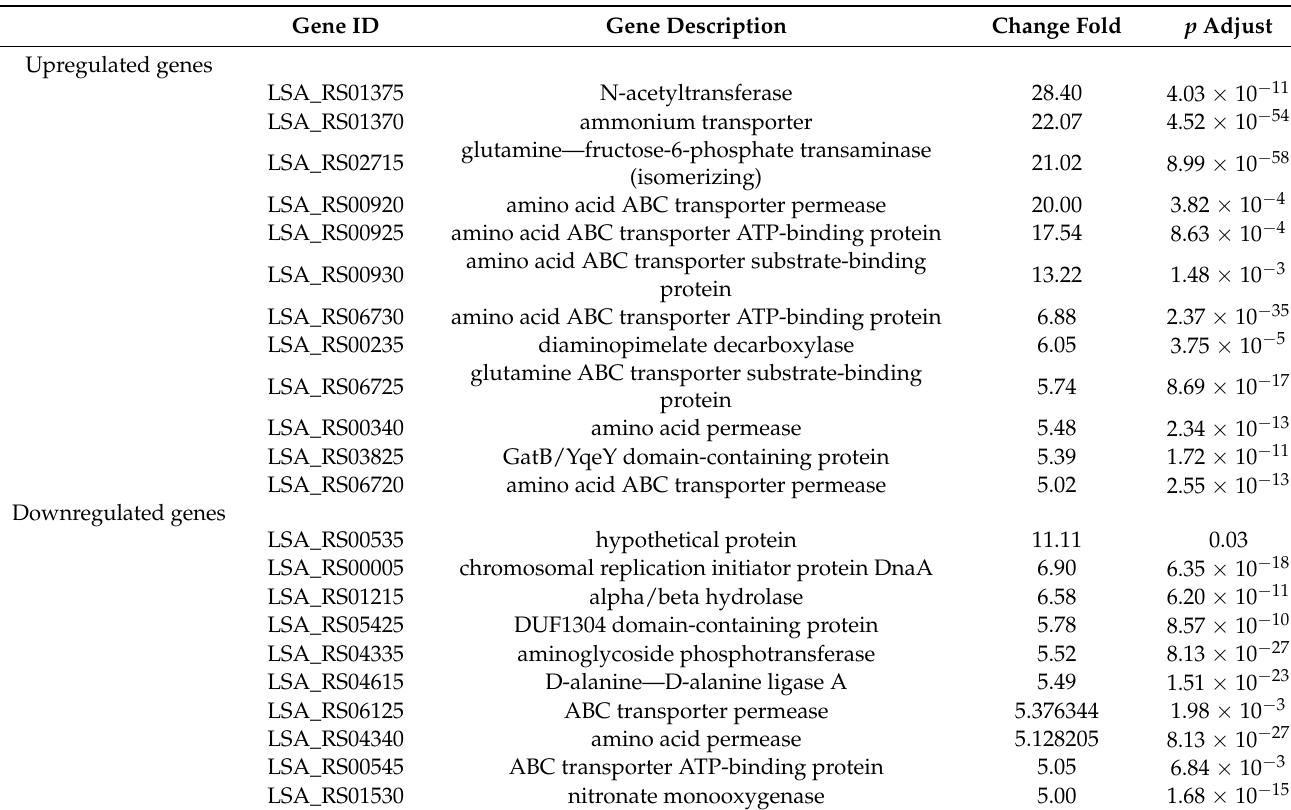
Table 2. The most changed genes (change fold > 5) in F. sanfranciscensis LS1 during sourdough fermentation (co-fermentation vs. single